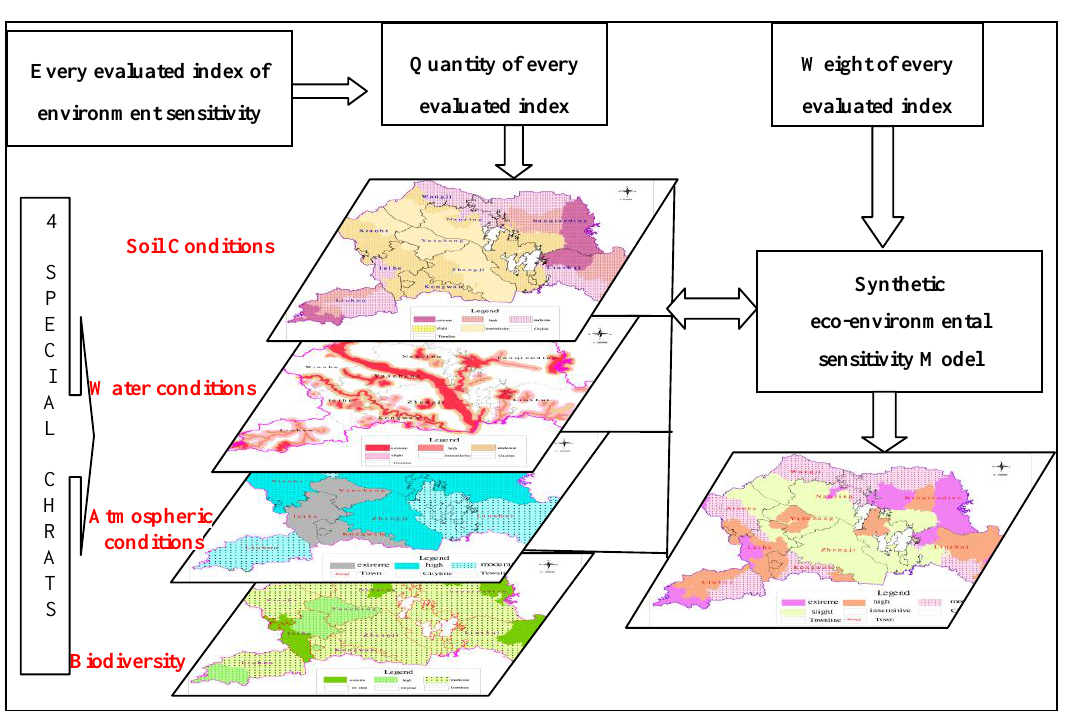
Figure 2. Technique of synthetic eco-environmental sensitivity for land use